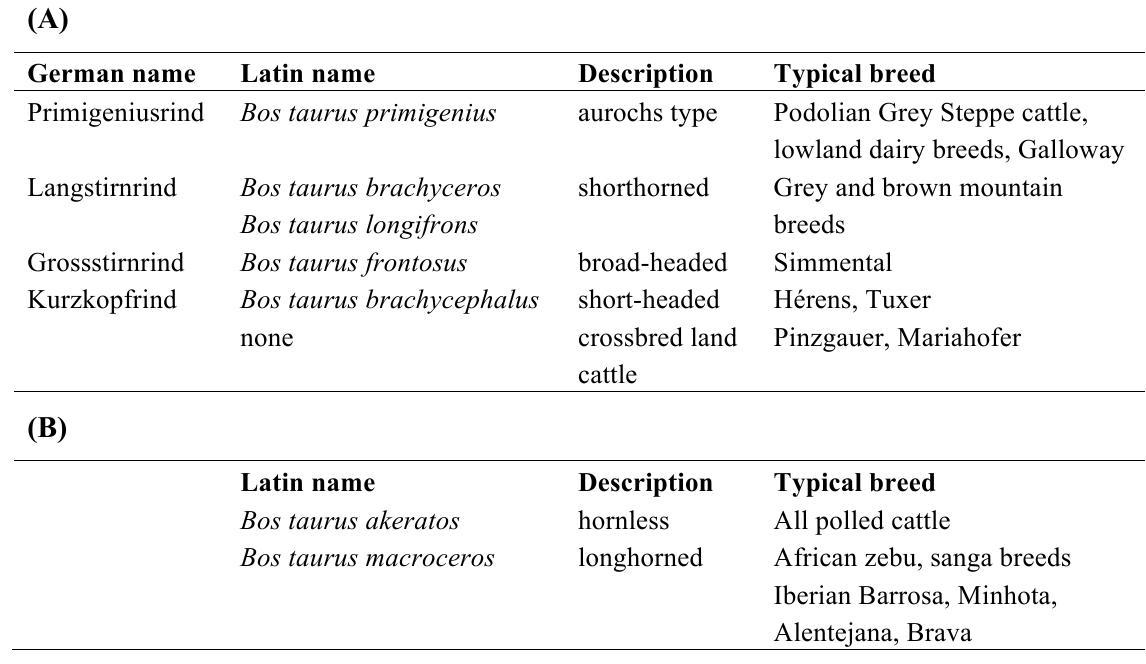
Table 1. ( A ) Classification according to Wilckens [26] and Werner [27] and ( B ) additional types according to Dürst [28], the first of which was also adopted by Keller [29], Adametz [30] and Holecek Holleschowitz